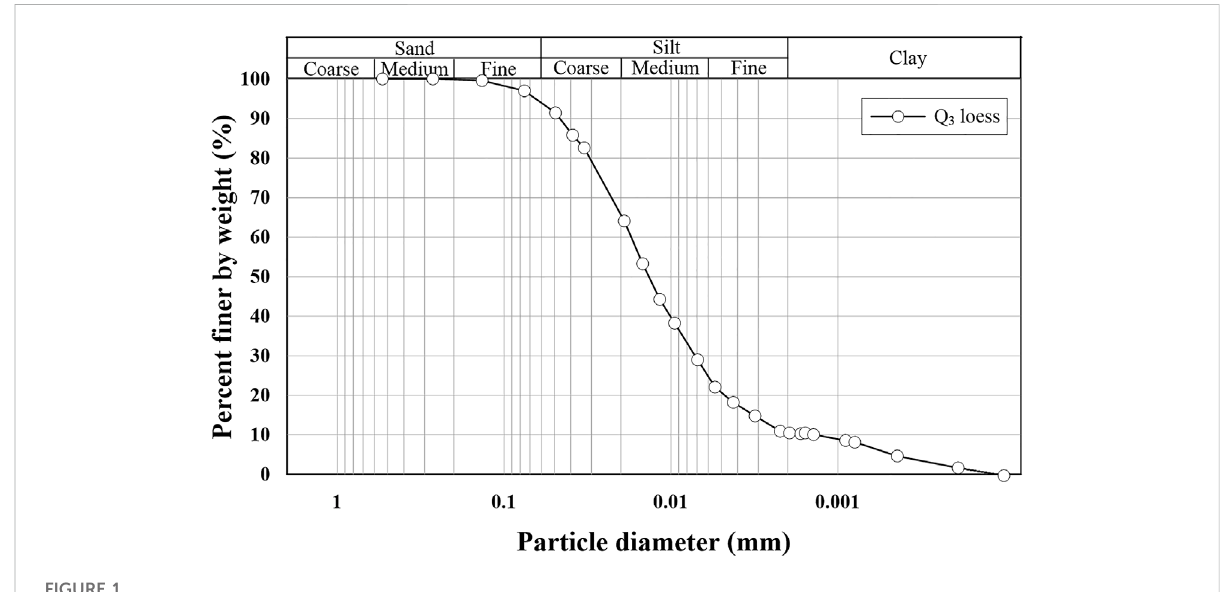
FIGURE 1 Particle-size distribution of the loess.